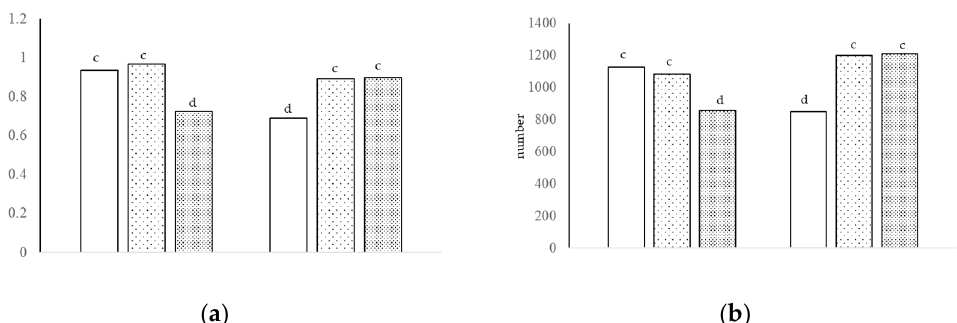
Figure 2. The villi area [( a ), interaction of growth promoter and type of diet, c,d p < 0.01; SEM = 0.057] and number of neutral cells [( b ), interaction of growth promoter and type of diet, c,d p < 0.01; SEM = 81.758] in the jejunum at day 38.